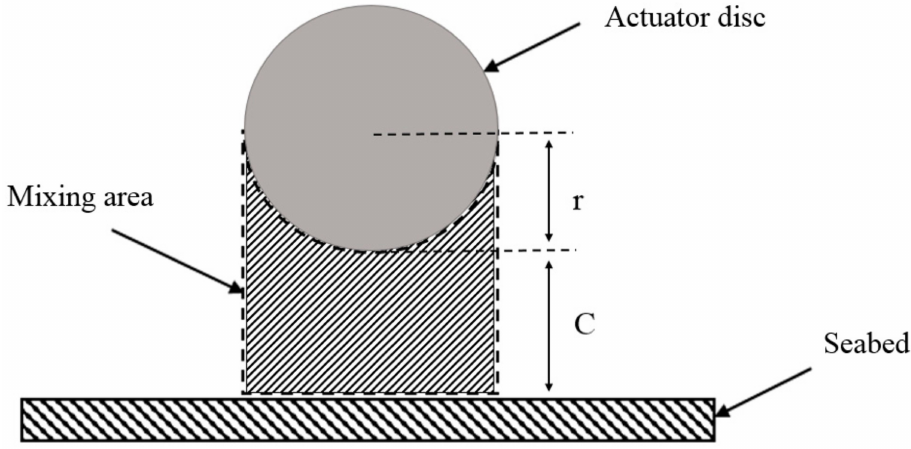
Figure 4. Mixing area calculated in the predicted